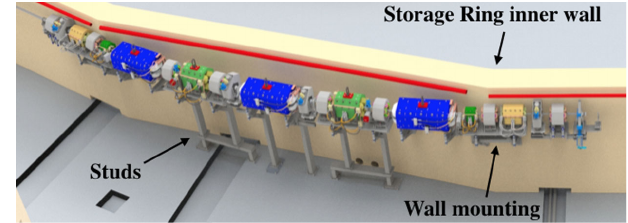
FIG. 5. Schematic drawing of an arc section of the ALS-U accumulator ring. The magnets are mounted to the inner storage ring wall, partially supported by vertical studs.